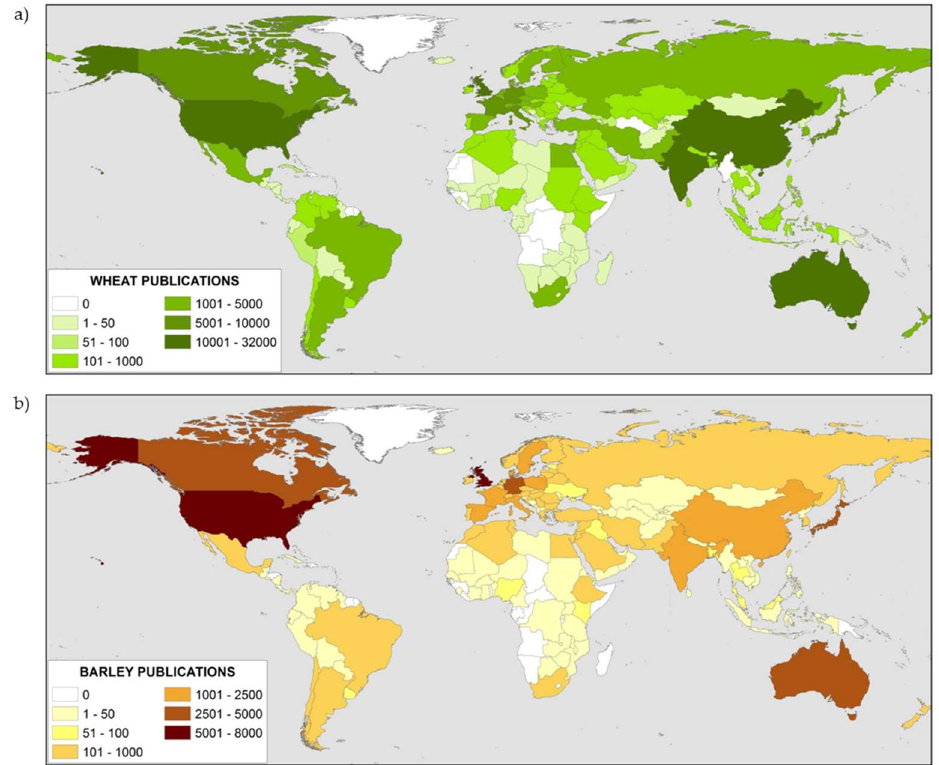
Figure 2. Worldwide research on wheat ( a ) and barley ( b ) up to 2018.